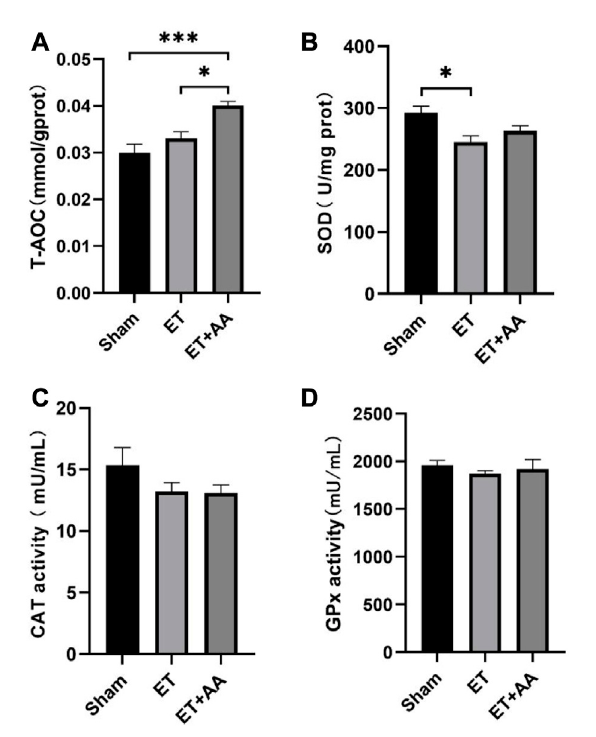
FIGURE 9 T-AOC and enzyme activities of kidney tissue 4 h post-ET in the sham, ET, and ET + AA group. (A) Total Antioxidant Capacity. (B) , SOD activity. (C) , CAT activity. (D) , GPx activity. Values are expressed as mean ± SEM, n =